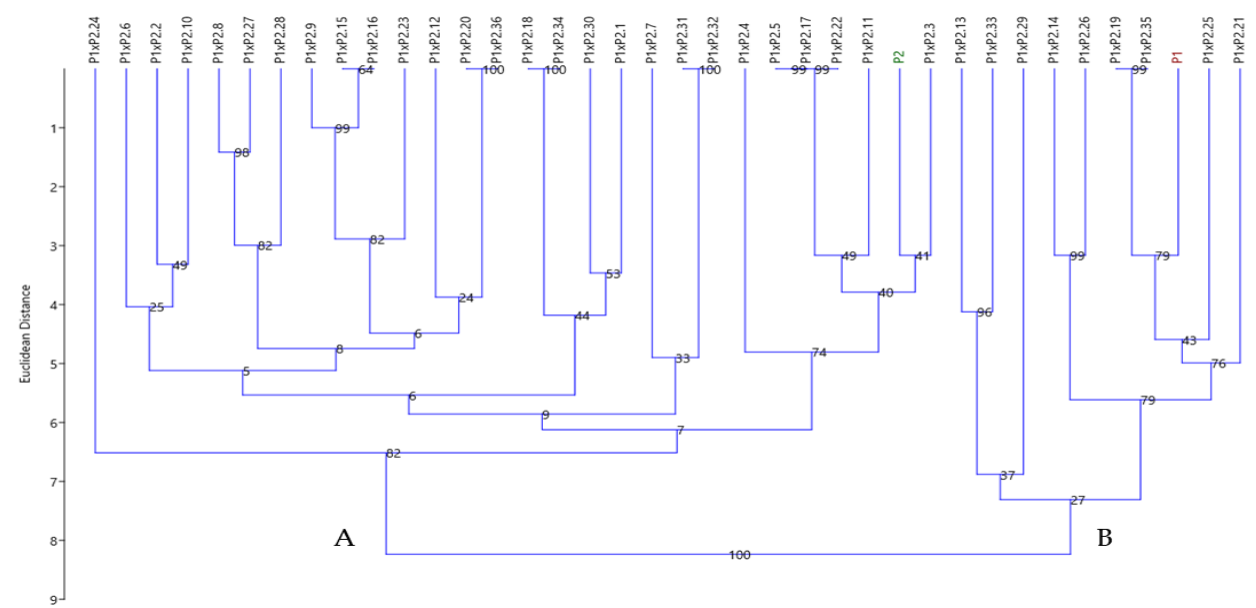
Figure 7. UPGMA dendrogram generated by SCoT markers, showing the relationships between parents (P1 and P2) and F 1 plants from P1 × P2 cross and based on Euclidean’s distance index. Numbers on the branches show bootstrap values, computed from 10,000 replications. In dendrogram, the mother parent is marked with red color, while the father parent is marked with green